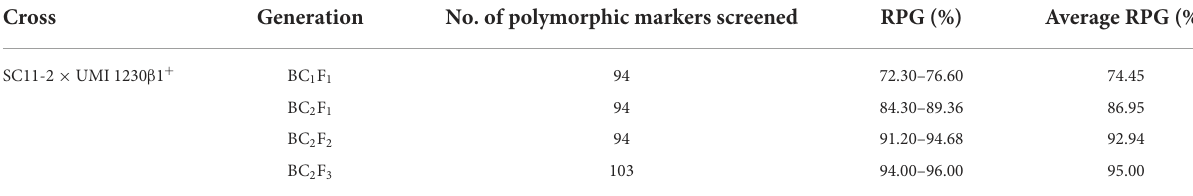
TABLE 2 Recovery percentage of recurrent parent genome in backcross and selfed populations derived from SC11-2 × UMI 1230 β 1 + . Cross Generation No. of polymorphic markers screened RPG (%)